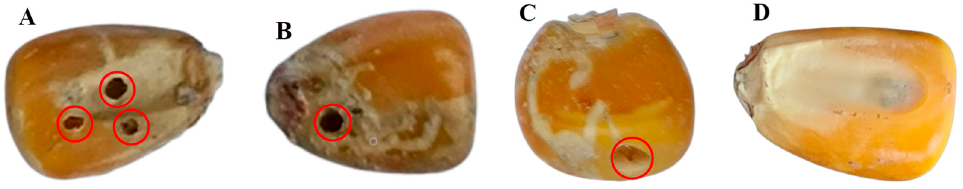
Figure 1. Images of maize seed samples: ( A ) embryonic surface worm-eaten; ( B ) non-embryonic surface worm-eaten; ( C ) lateral surface worm-eaten; ( D ) healthy.